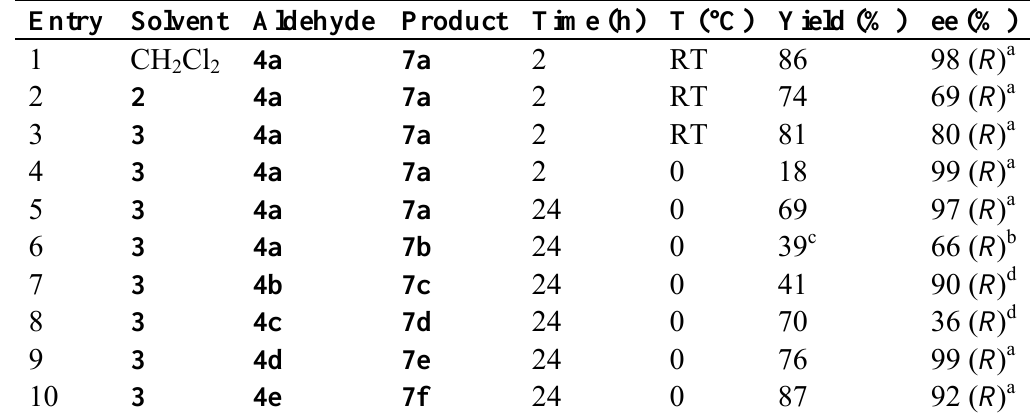
Table 1. Effect of solvent and temperature on proline-catalysed α -hydrazinations of